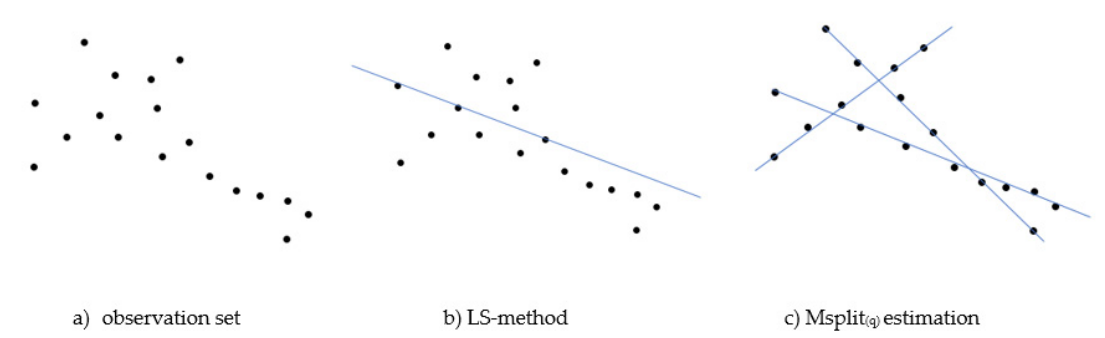
Figure 2. The idea of Msplit (q) estimation and the Least Square method, with the example of